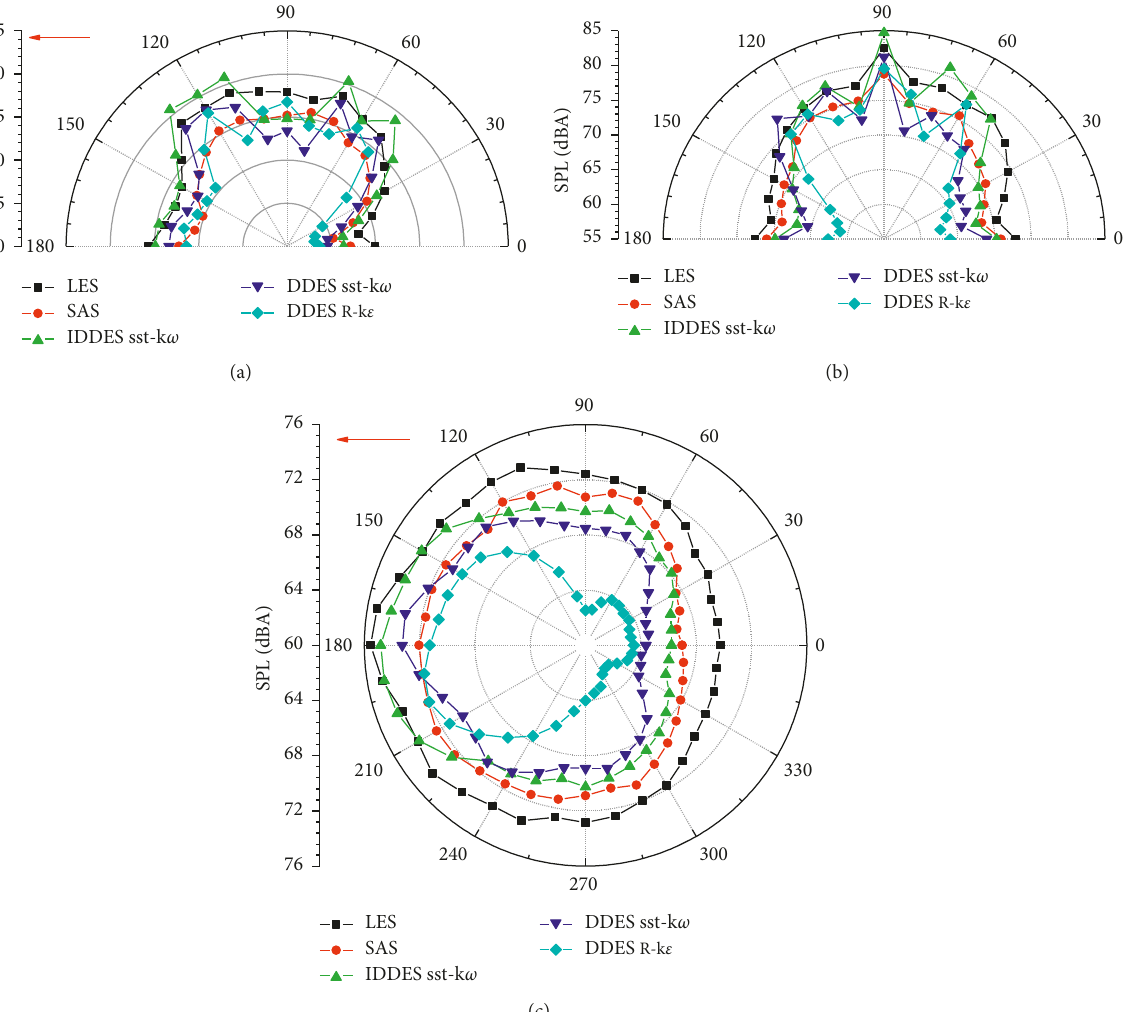
Figure 20: Far-field directionality of radiated noise from pantograph (350 km/h): (a) directionality 1- xz plane; (b) directionality 2- yz plane; (c) directionality 3- xy plane. The arrow in the picture denotes the direction of airflow.